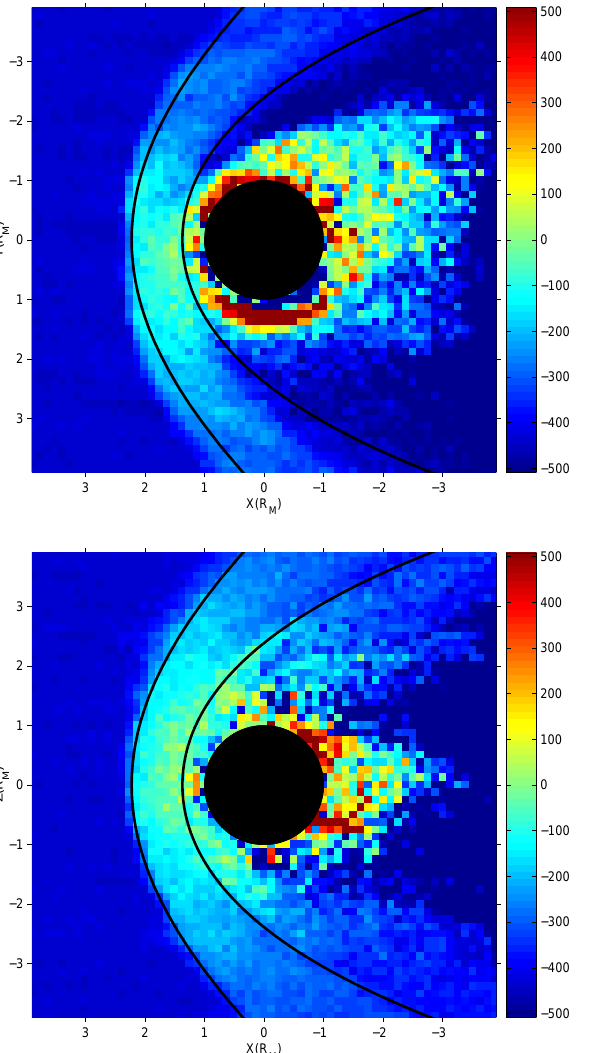
Fig. 6. The velocity of the solar wind protons perpendicular to the x -axis: (top) U y (H + ) on the XY -plane and (bottom) U z (H + ) on the XZ -plane in kms − 1